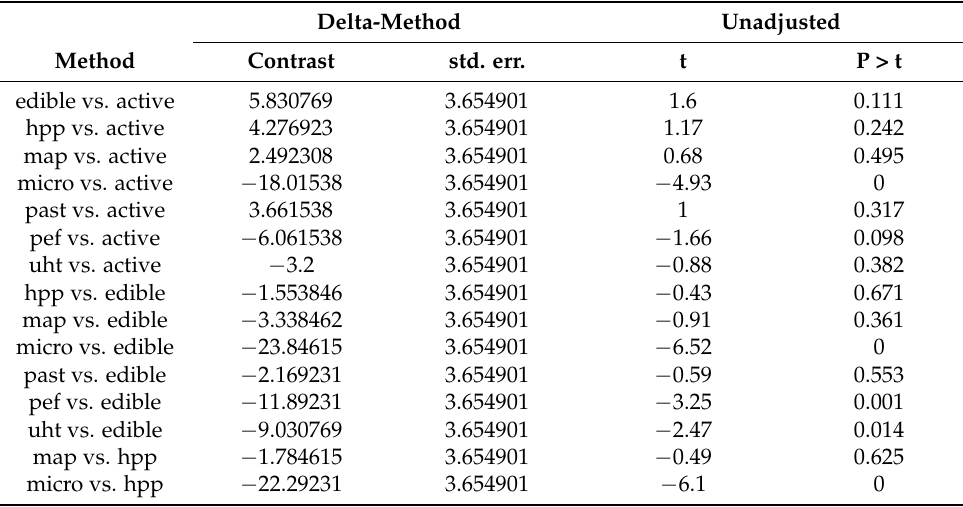
Table A3. Pairwise-comparisons of predictive margins for color-coded